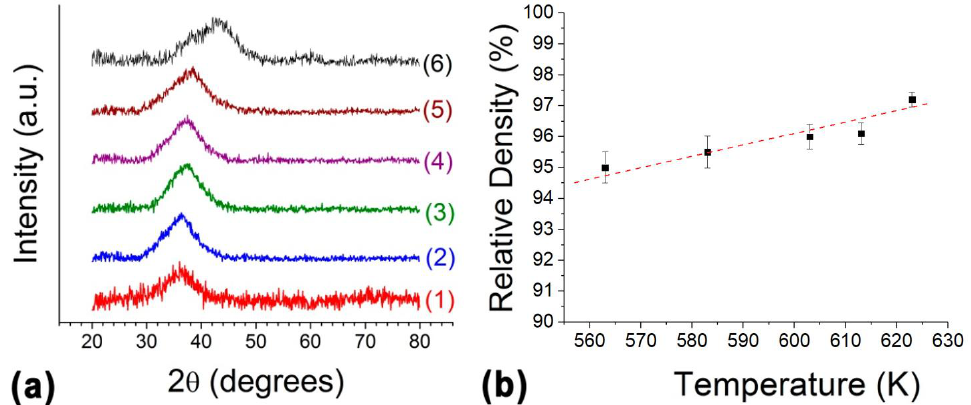
Figure 8. ( a ) XRD patterns of amorphous Al 82 La 10 Fe 4 Ni 4 samples: (1) as-milled powder and sintered at SPS at (2) 543, (3) 563, (4) 583, (5) 603 and (6) 623 K, under pressure of 500 MPa, 3 min holding. ( b ) Relative densities as a function of the SPS temperature.